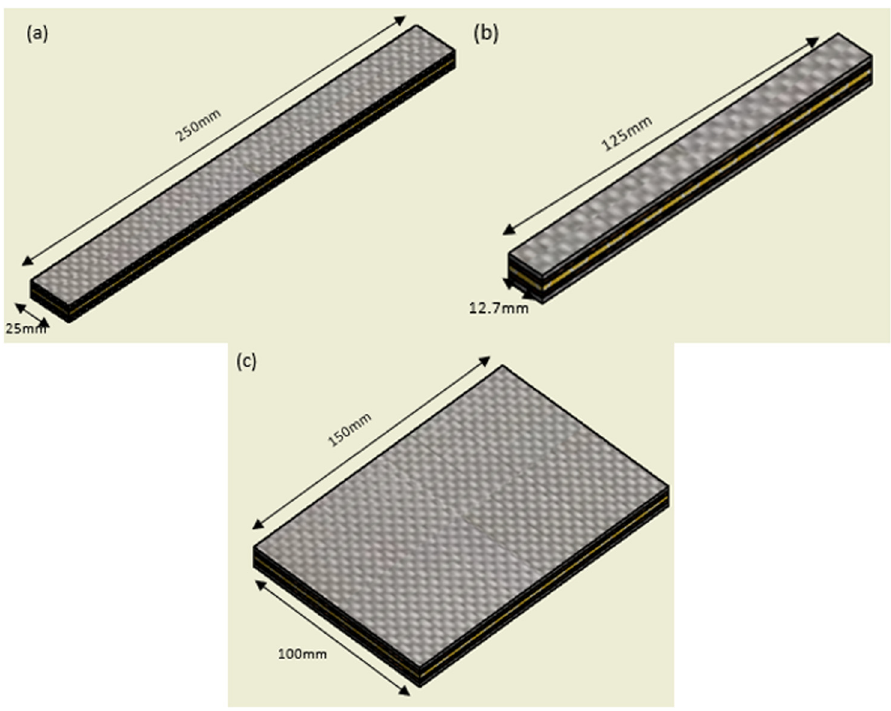
Figure 1: Composite sample sizing according to ASTM standard: ( a ) tensile ASTM D638, ( b ) fl exural ASTM D790, and ( c ) low - velocity impact ASTM D7136M.